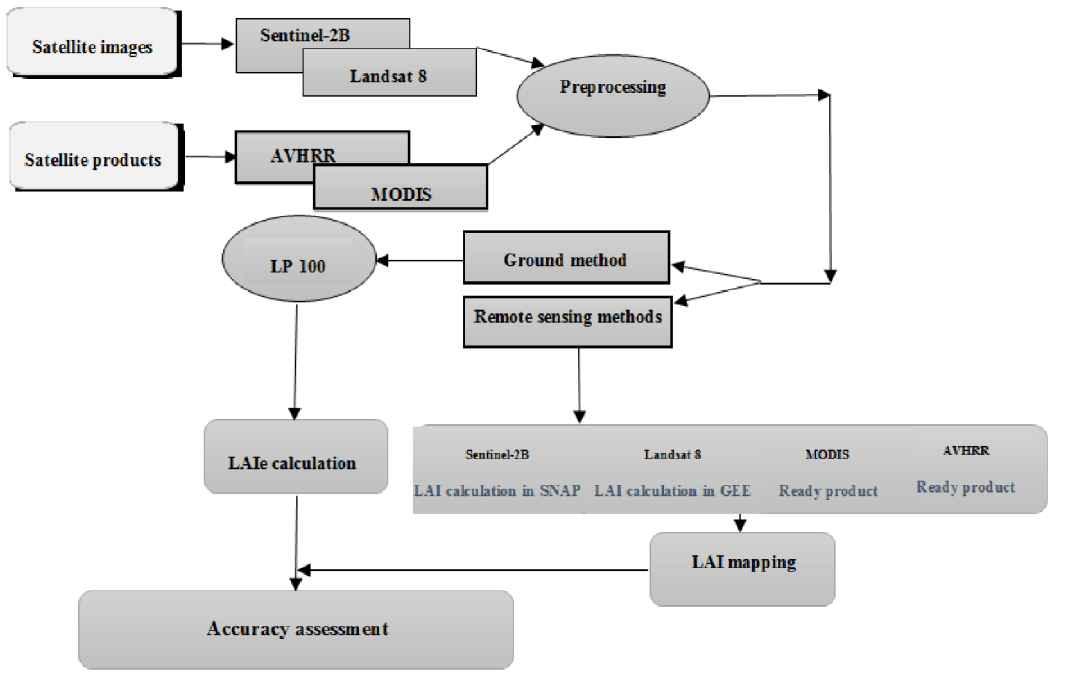
Figure 3. Methodological flowchart of the present study.